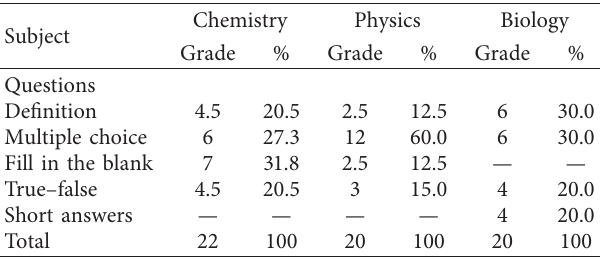
Table 9: Final examinations’ grading distribution of substantive questions for chemistry, physics, and